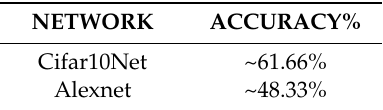
Table 6. Table with comparison of Cifar10Net and AlexNet networks (test carried out on 60 frames—30 standard, 30 random).